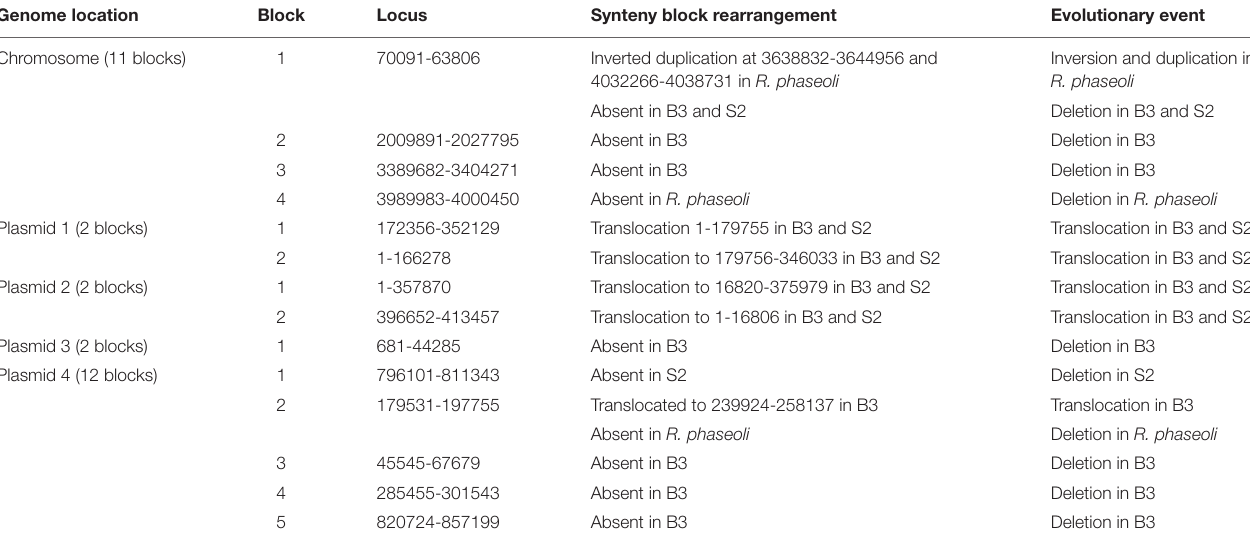
TABLE 4 | An analysis of synteny blocks between R. phaseoli and isolates B3 and S2. Genome